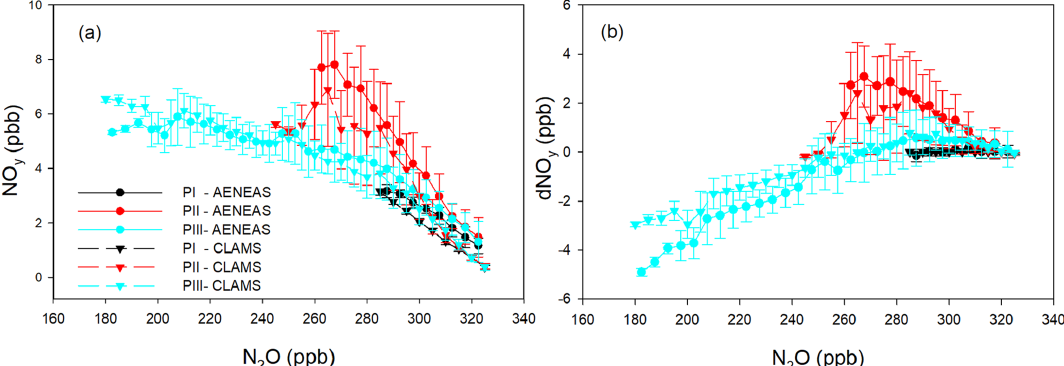
Figure 17. (a) NO y and (b) dNO y averaged over 5ppb N 2 O intervals along with standard deviations for the three mission phases. Observed values (circles) are shown along with values from the CLaMS model simulation